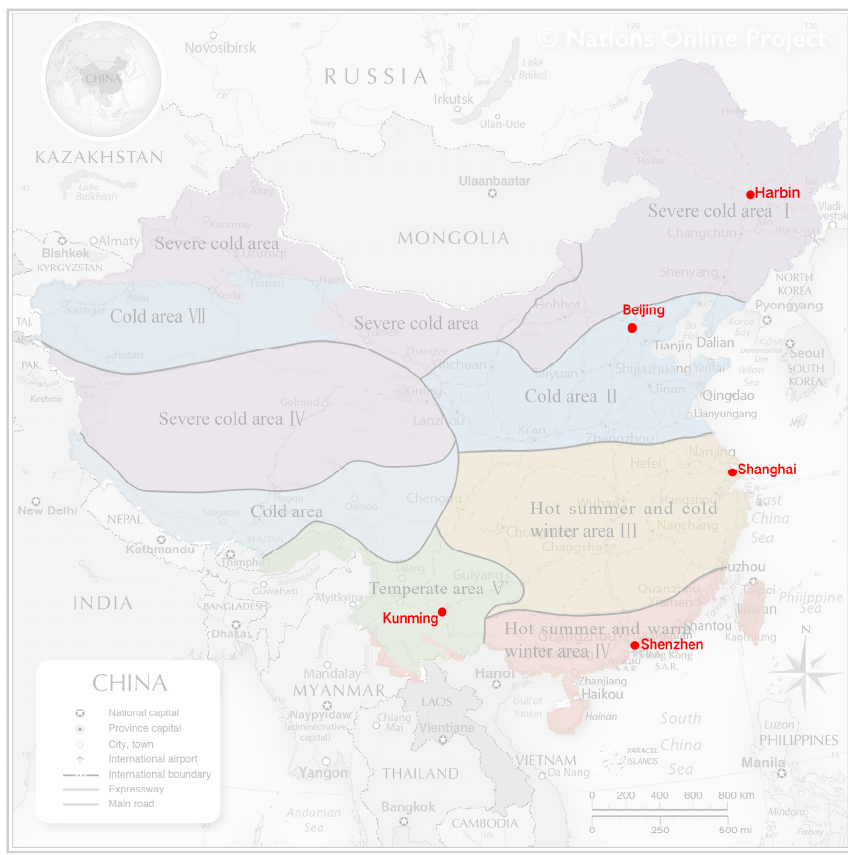
Figure 1. Location of typical cities in